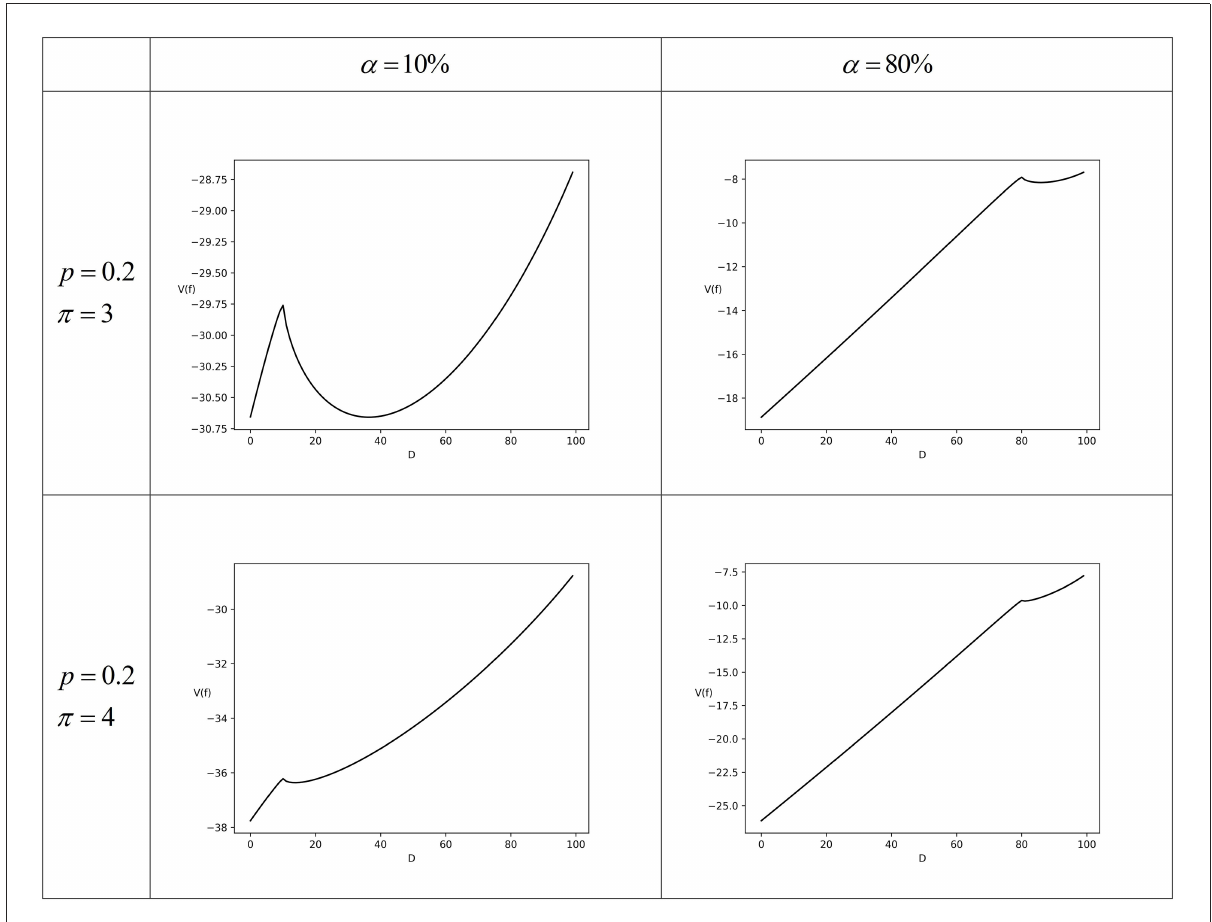
FIGURE3 The numerical simulation for Scenario 3 (complete tax